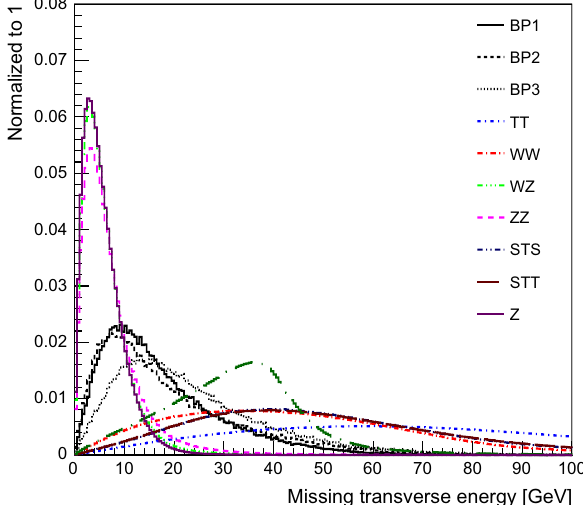
Fig. 4 The distribution of missing transverse energy in signal ( (cid:2)(cid:2) HjjH ) and background